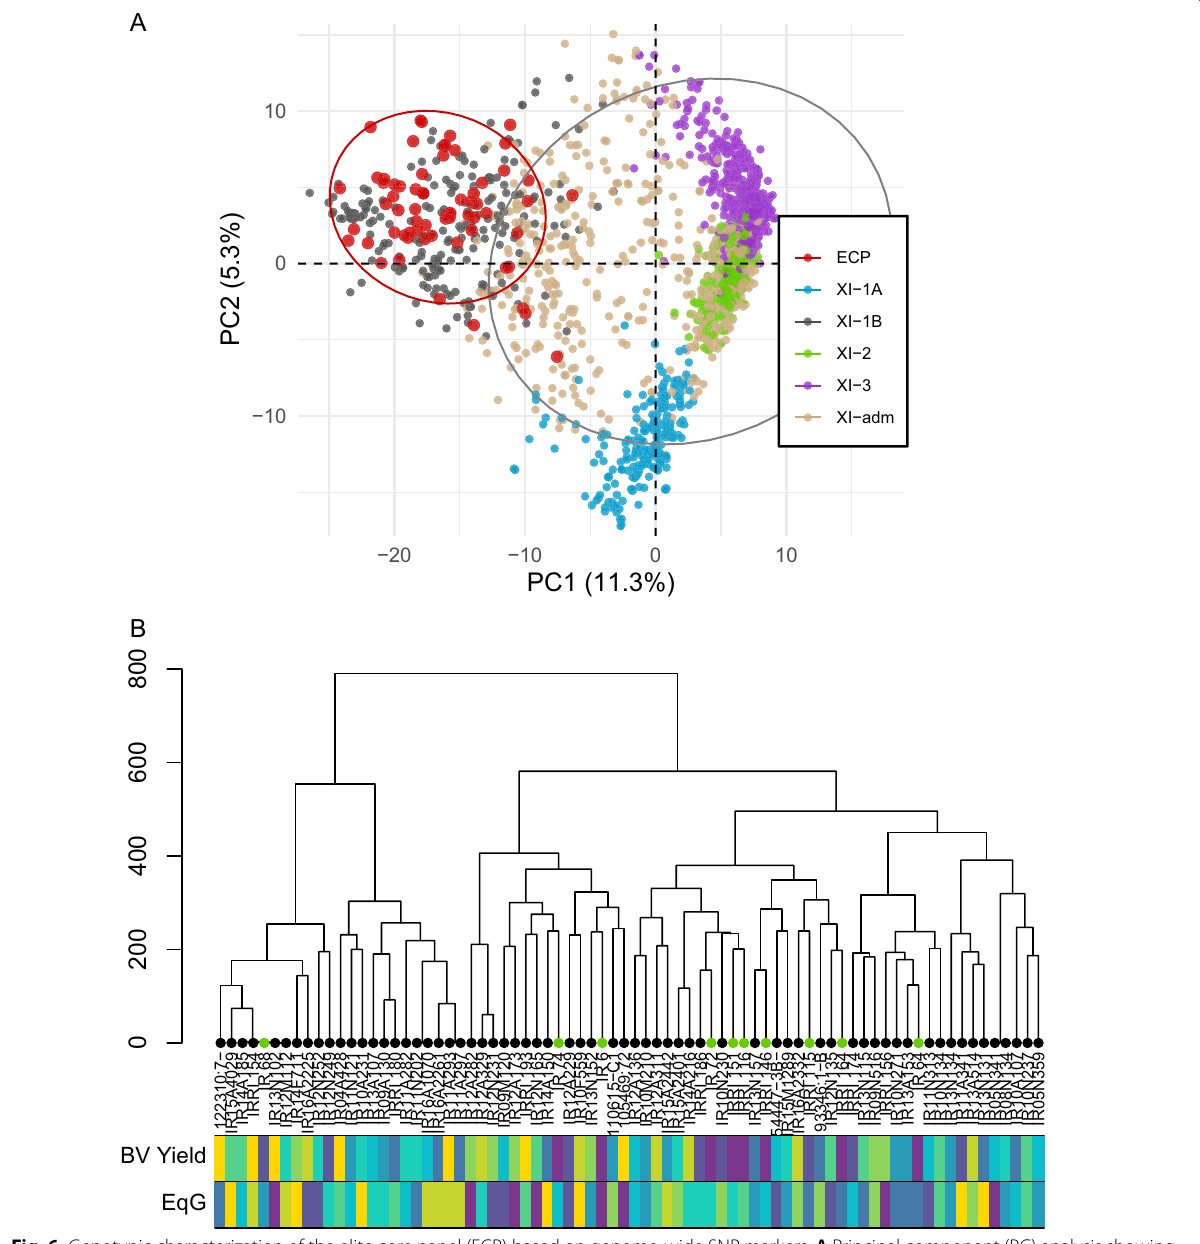
Fig. 6 Genotypic characterization of the elite core panel (ECP) based on genome-wide SNP markers. A Principal component (PC) analysis showing the grouping of ECP with Xian/indica (XI) group from the 3K-RG lines. B Dendrogram showing the relationship between ECP lines and with IRRI varieties (green dots). The heatmap at the bottom represents the breeding value for yield (BV Yield) and the equivalent complete generation (EqG) from the lowest (purple) to the highest (yellow)